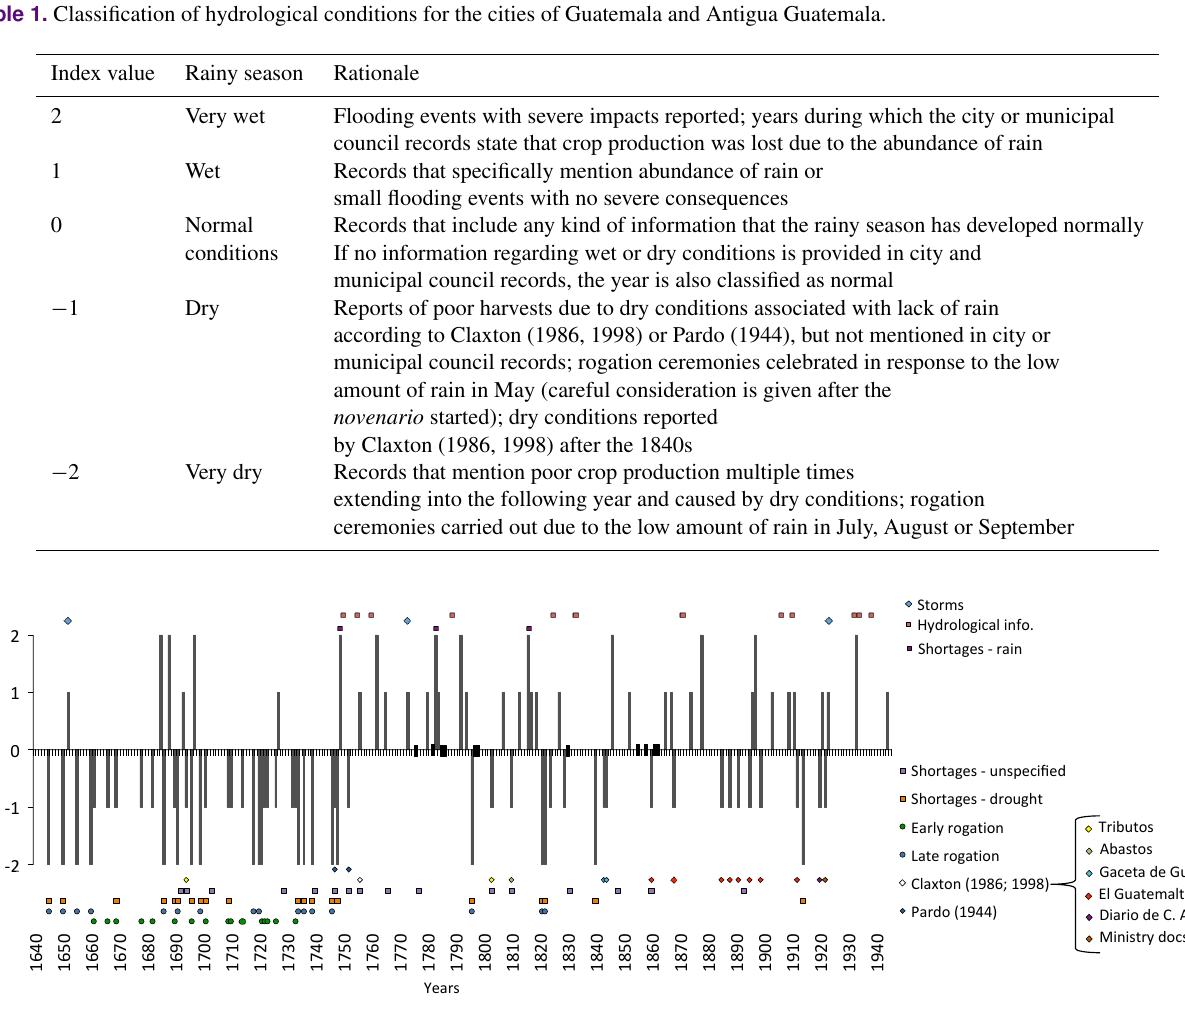
Figure 4. Five-category semi-quantitative hydrological index for the cities of Antigua Guatemala and Guatemala City starting in 1640 and ending in 1945. Rainfall in each year is classified as very dry =− 2, dry =− 1, normal = 0, wet = + 1 and very wet = + 2 based on the information obtained from the city and municipal council records of both cities of the Republic of Guatemala and complemented with the information from Claxton (1986, 1998) and Pardo (1944). All storms or temporales , early and late rogation ceremonies, years with hydrological information not considered sufficiently detailed to enable classification of the year as wet, and food shortages, whether or not the cause was specified, are indicated. The years in which the studies of Pardo (1944) and Claxton (1986, 1998) are used to reconstruct rainfall variability are also indicated. The black blocks mark where there are missing or damaged books and no information is